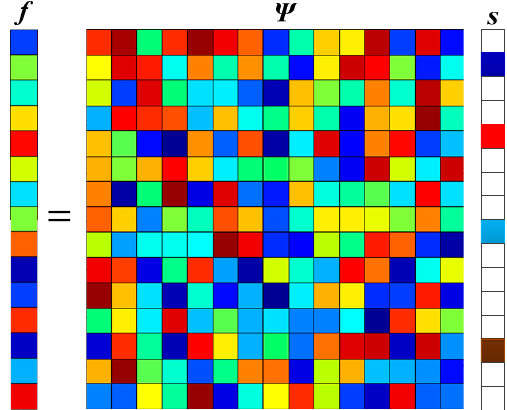
Figure 2. Sparse representation of signal f.